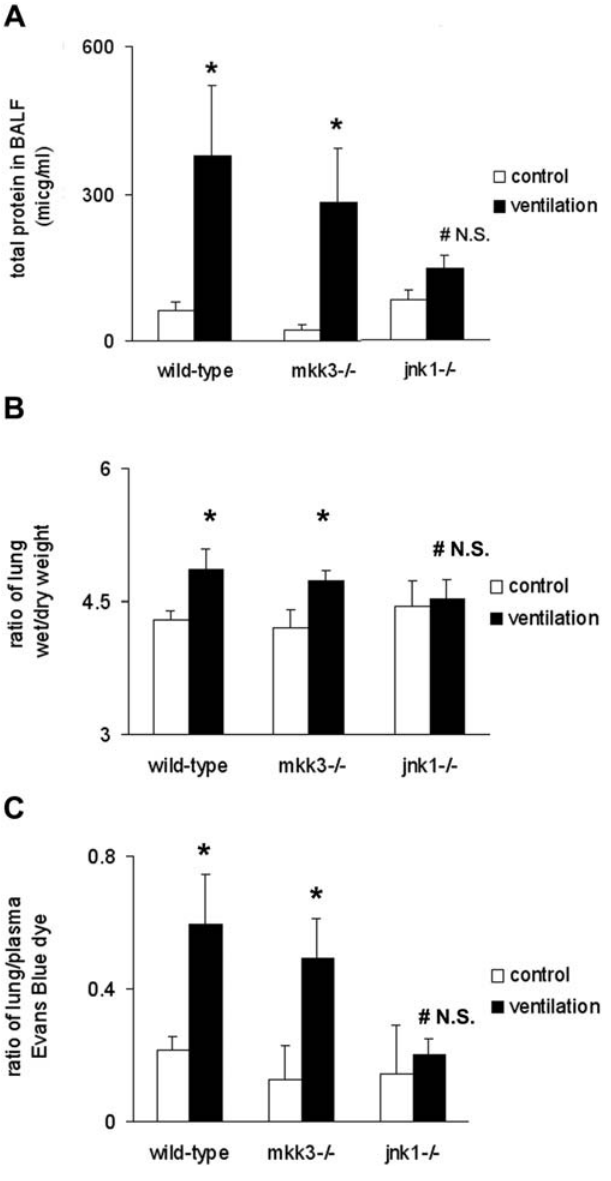
Figure 6. Alveolar protein content, lung microvascular perme- ability, and wet-to-dry weight ratio measurement in wild-type, mkk3 2 / 2 and jnk1 2 / 2 mice. (A) Total protein levels were significantly increased in wild-type and mkk3 2 / 2 mice following ventilation (20 ml/ kg, 4 hours). No differences in total protein levels were observed in the jnk1 2 / 2 mice. (B) Wild-type and mkk3 2 / 2 mice responded to mechanical ventilation with pulmonary edema formation (20 ml/kg, 4 hours). Pulmonary edema formation was quantified by measuring the wet and desiccated dry weight of lung tissue. No significant lung water changes were detected in jnk1 2 / 2 mice. (C) Increased microvascular permeability was detected with Evans Blue (EB) dye extravasation method in wild-type and mkk3 2 / 2 mice following mechanical ventilation (20 ml/kg, 4 hours). Mice lacking jnk1 gene did not show increased permeability following mechanical ventilation. Changes in permeability are expressed as a ratio of lung tissue/blood plasma to correct for differences in volumes of injected dye to the circulation.. *represents significant differences between control and ventilated animals. # N.S.=non-significant change between control and ventilated mice.